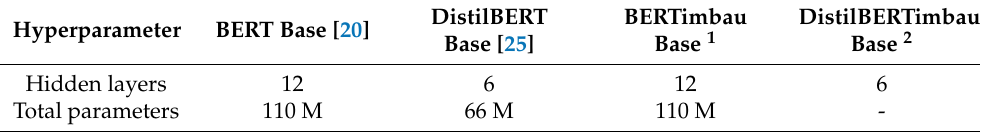
Figure 3. Overfitting example. Table 2. Model